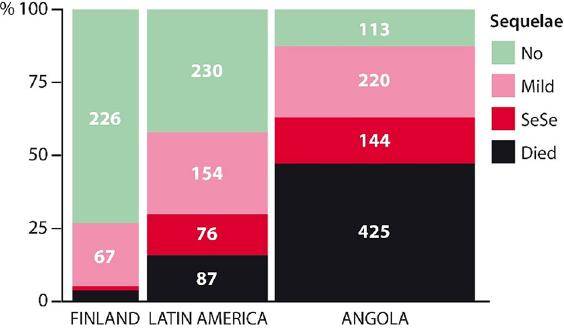
Figure 2. Main outcomes of 309, 547 and 902 cases from Finland, Latin America and Angola, respectively. Mild and severe sequelae (SeSe) defined in text. Bacteriologically confirmed and unconfirmed cases combined.